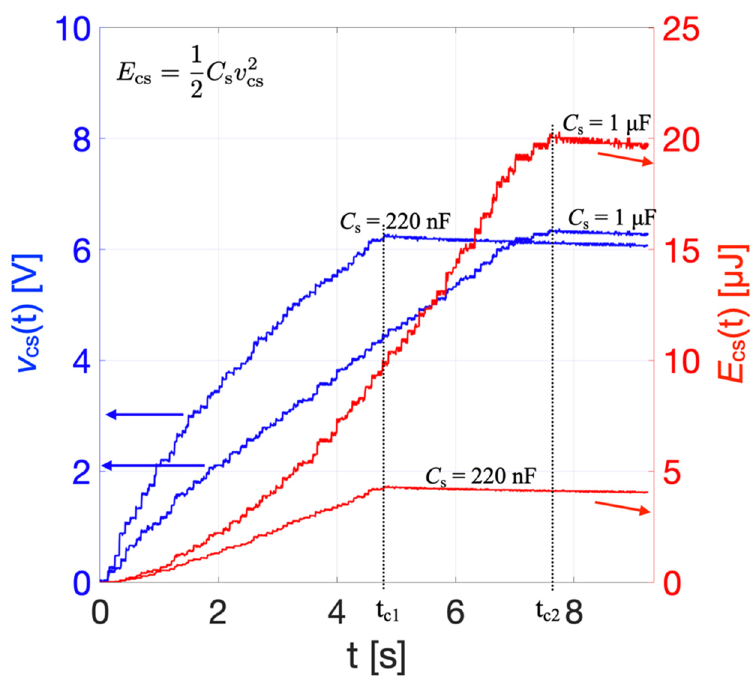
Figure 16. Measured rectified voltage v cs (t) (blue curves) and estimated electrical energy E cs (t) (red curves) stored employing two different values of storage capacitors C s .